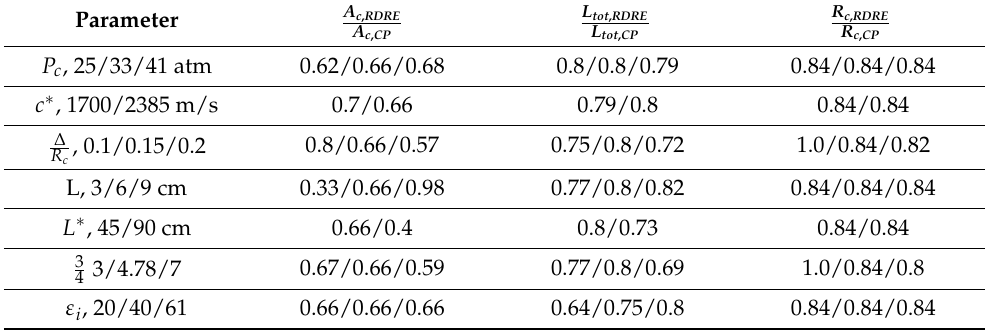
Table 3. Sensitivity of chamber dimensions and surface area to design inputs at a massflow rate of 10 kg/s.